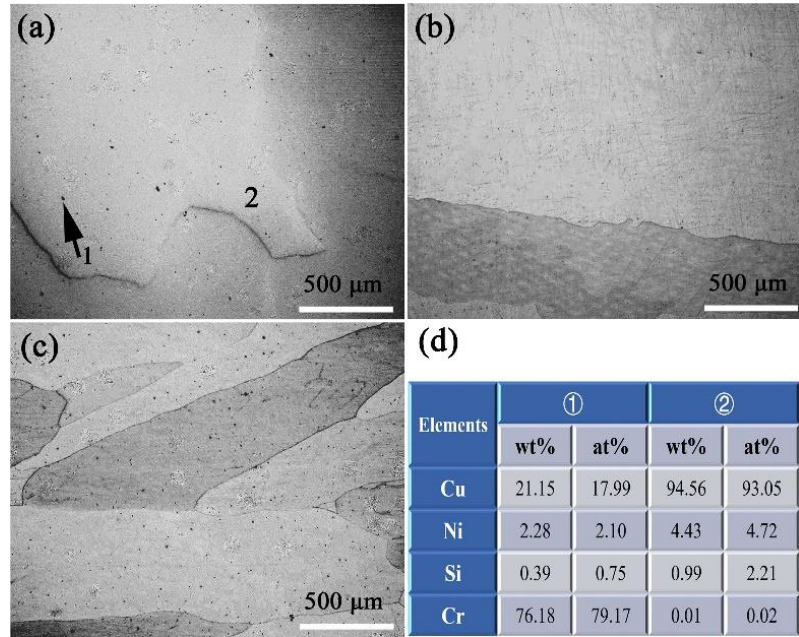
Figure 7. The evolution of microstructures of the Cu-Ni-Si alloy with increasing temperatures of solution treatment, containing SEM photographs at ( a ) 980 °C, ( b ) 1000 °C, and ( c ) 1020 °C, with the corresponding EDS data. ( d ) the EDS of position 1 and 2 in ( a ).